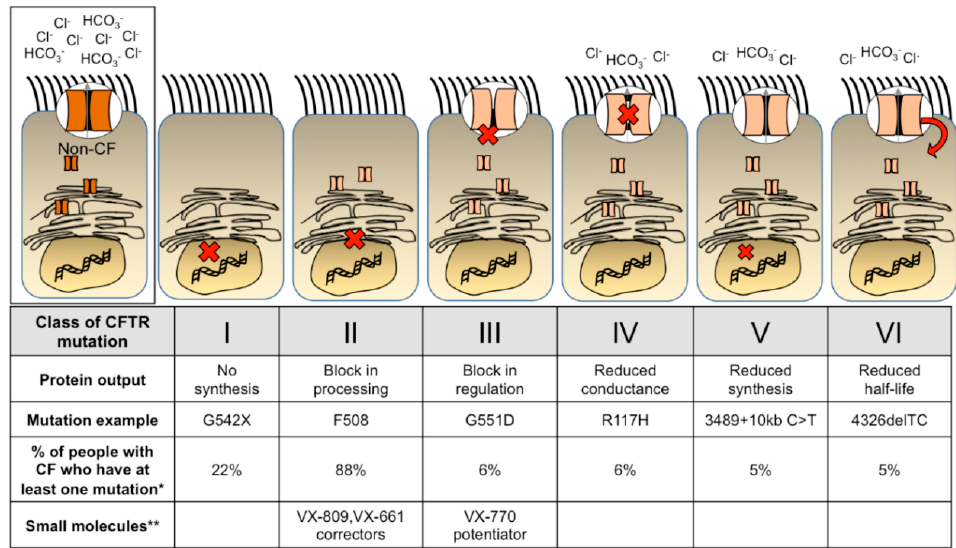
Figure 1. Classes of cystic fibrosis transmembrane conductance regulator (CFTR) mutations. Cystic fibrosis transmembrane conductance regulator mutations are categorized into 6 classes based on the mutation function or protein output [5]. A red “x” or arrow indicates where each CFTR mutant protein is affected. A common mutation example is listed for each class. * People with CF can have more than one mutation; thus, the percentage is representative of the entire population and does not add up to 100. Percentages acquired from the Cystic Fibrosis Foundation (U.S., 2017). ** Potentiators and correctors provide relief to some people with CF in these classes. Additional mutations have been approved for use of CFTR modulators.